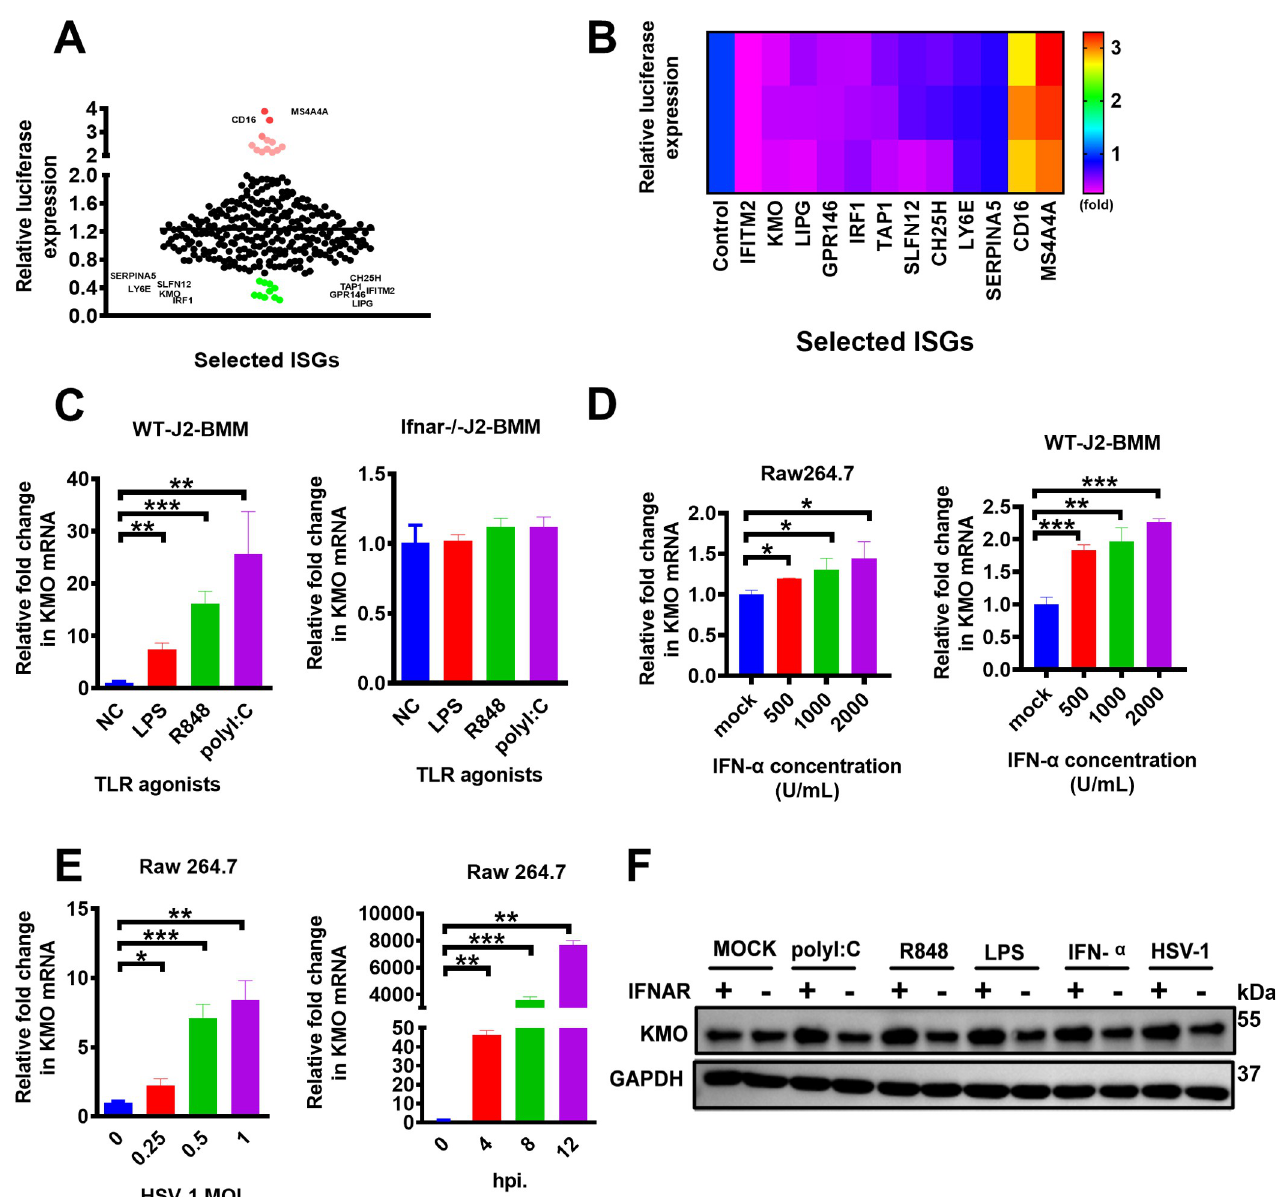
Fig 1. The expression of KMO is interferon-inducible. (A,B) 288 genes were screened by a luciferase-based analysis. Each dot represents one gene, and its effect on HSV-1 infection was normalized to that in pVAX-GFP transfected cells (negative control). Genes that inhibit HSV-1 infection by more than 50% were marked and shown in green. Genes that enhance HSV-1 infection by more than 2 fold were marked and shown in red. (C) Wild type bone marrow-derived macrophage (WT-J2-BMM) cells or interferon α receptor-deficient ( Ifnar -/- )-J2-BMM cells were stimulated for 8 h with different TLR agonists, including LPS (1 μ g/mL), R848 (100 nM), poly(I:C) (25 μ g/mL), and then the expression level of kmo gene was measured by RT-qPCR. (D) Raw264.7 cells and J2-BMM cells were stimulated with IFN- α in different concentrations (500 U/mL, 1000 U/mL, and 2000 U /mL) for 8 h, and the expression level of the kmo gene was measured by RT-qPCR. (E) Raw264.7 cells were infected with indicated MOI of HSV-1 for 24 h or infected with various times (hours post-infection, hpi.) at 0.25 MOI of HSV-1. Then, the expression level of the kmo gene was measured by RT-qPCR. (F) J2-BMM cells and Ifnar -/— J2-BMM cells were stimulated with LPS (1 μ g/mL), poly(I:C) (25 μ g/mL), R848 (100 nM), IFN- α (2000 U/mL), or HSV-1 at MOI of 0.25 for 24 h, respectively, and then the expression level of KMO protein was measured by Western Blotting Analysis. GAPDH was used as intern control. The final data are presented as the mean ± SD of at least triplicate experiments. MOI: multiplicity of infection. � P < 0.05, �� P < 0.01, ��� P < 0.001.